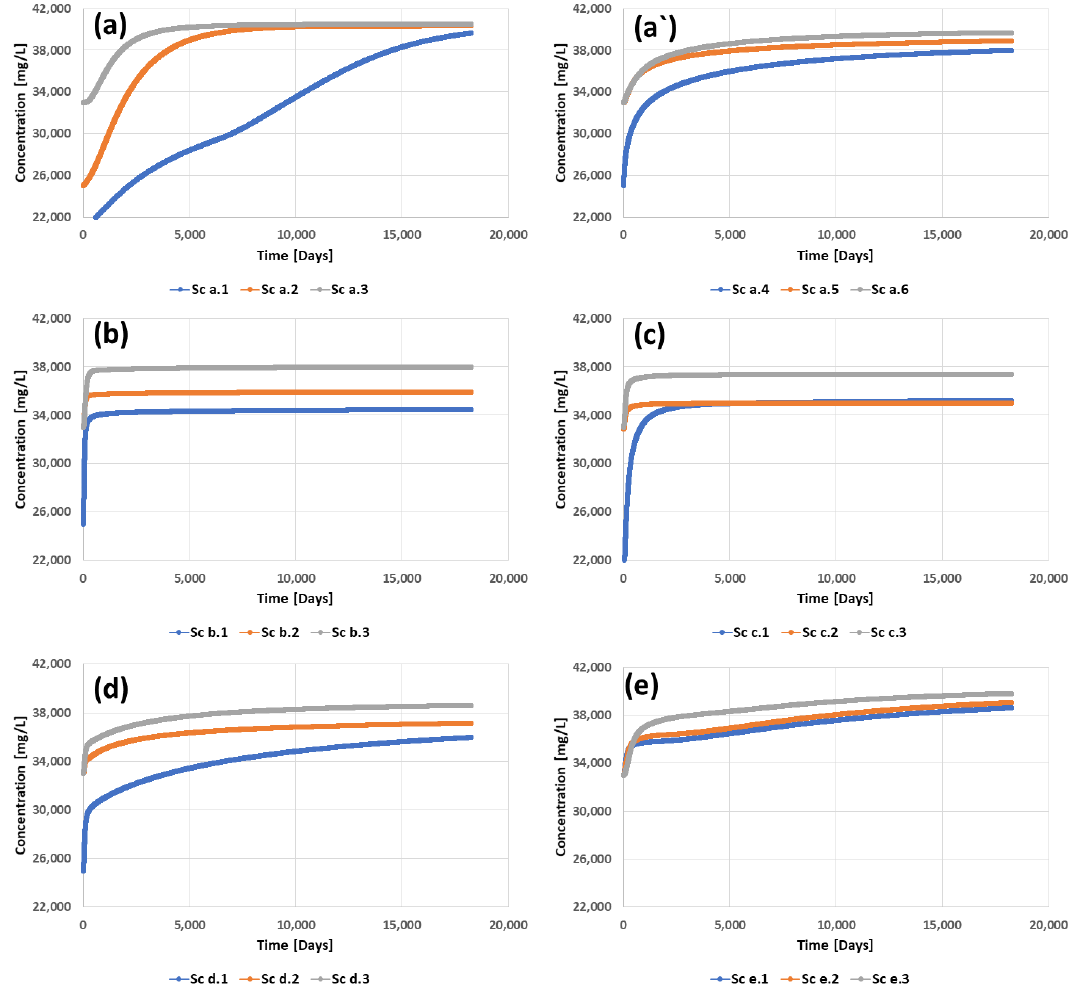
Figure 12. Predicted salinity curves over 50 years for scenario a ( a , a` ), scenario b ( b ), scenario c ( c ), scenario d ( d ) and scenario e ( e ) at one control point (GW 02).